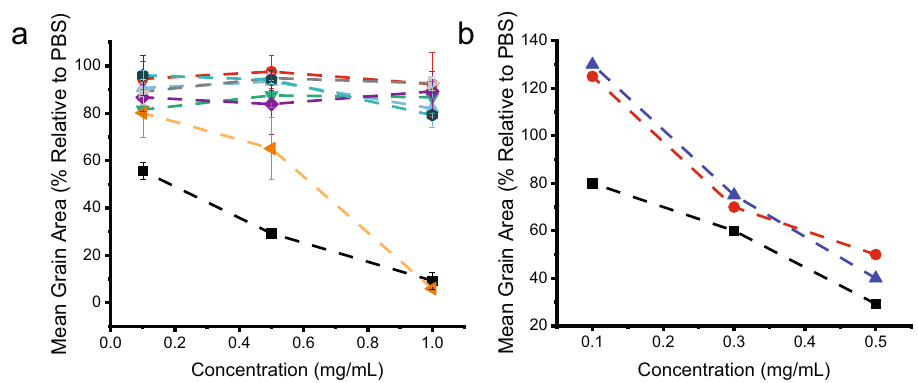
Fig. 6 Ice recrystallization inhibition activity of peptides listed in Fig. 7. a Mean grain area analysis of IRI activity of the peptides listed in Fig. 7. All IRI assays were performed in oxidizing conditions unless otherwise noted. Black squares represent the oxidized peptide 8 . The red circle is reduced peptide 8 . Orange triangles are Thr4-Ser mutation. Purple diamonds are Thr10-Ser mutation. Green triangles are Thr14-Ser mutation. Blue triangles all Thr have been mutated to Ser. Grey triangles is a scrambled peptide sequence. Teal hexagons Asp8-ser mutation. (values reported are averaged from three individual experiments and shown as mean data values ± SD. Error bars represent standard deviation). b Mean grain area IRI activity comparison of peptide 8 (black squares) to literature reported values for polyvinyl alcohol (PVA56) (red circles) and a truncated type I antifreeze protein 22 amino acids in length modi fi ed with anthracene (PC-AFP 22 monomer) (blue triangles) 29 .